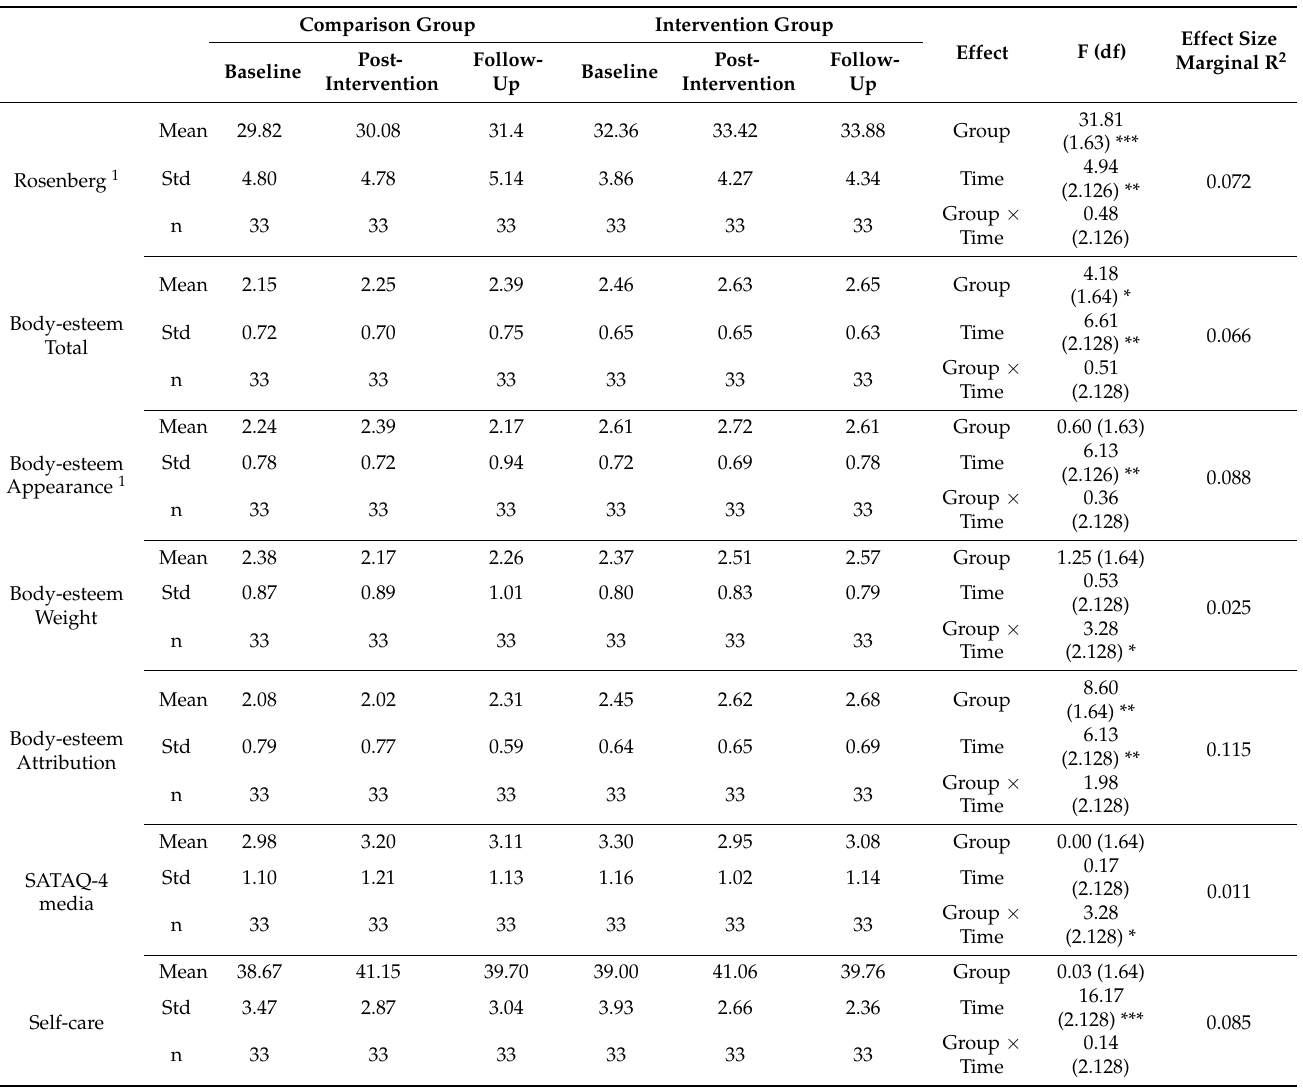
Table 5. Differences in outcome measures between groups and changes within each group (parametric outcome